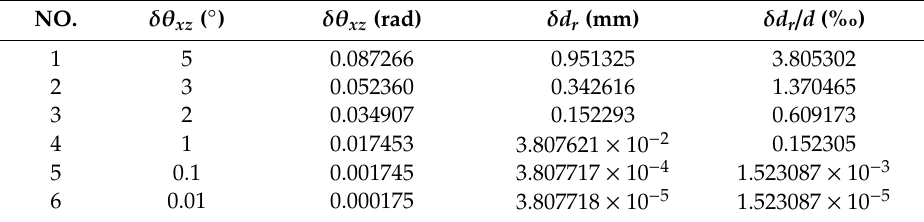
Table 5. Analysis of the influence of the USBL rotation angle error on the positioning error.